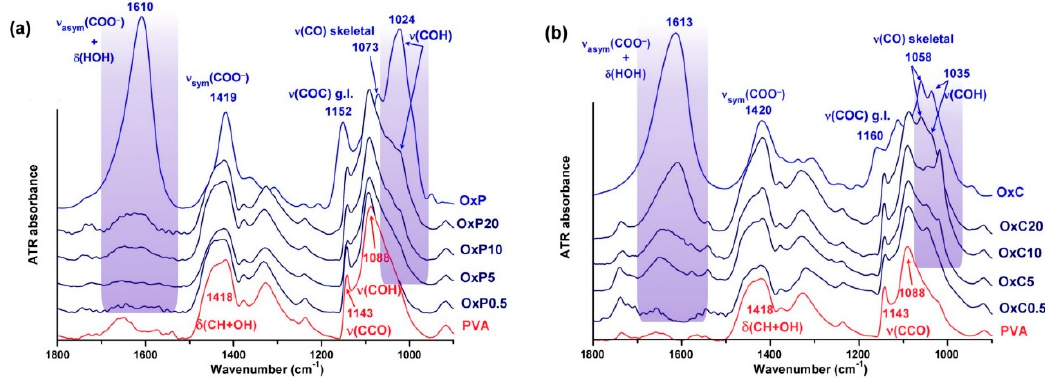
Figure 2. The fingerprint region of attenuated total reflection (ATR)-FTIR spectra of the poly(vinyl alcohol) ( PVA) hydrogels, in comparison with the neat PVA and OxP/OxC: ( a ) OxP-PVA; ( b ) OxC-PVA.